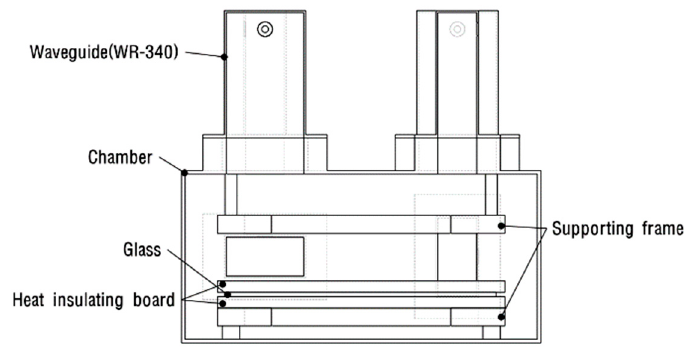
Figure 1. A schematic illustration of the 6 kW microwave chamber model used in the current study.